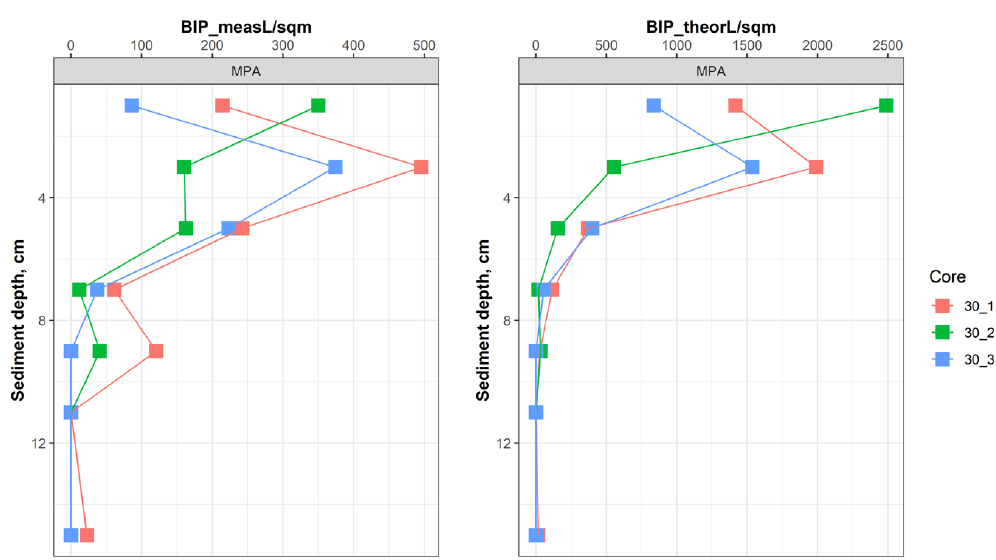
Table 4. Spearman rank correlation coefficients between the estimated total effluxes from sediments obtained from Lipka [41] and trait-based bioturbation and bioirrigation indices, BPc and BIPc ( n = 12). Significant values ( p < 0.05) are highlighted in bold.